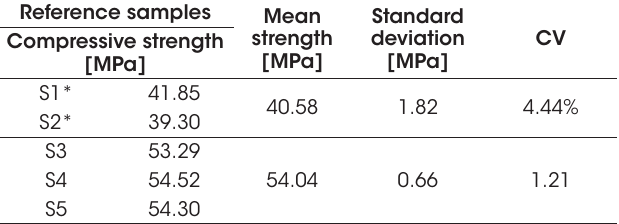
Compressive strength of additional samples cast in horizontal PVC tubes